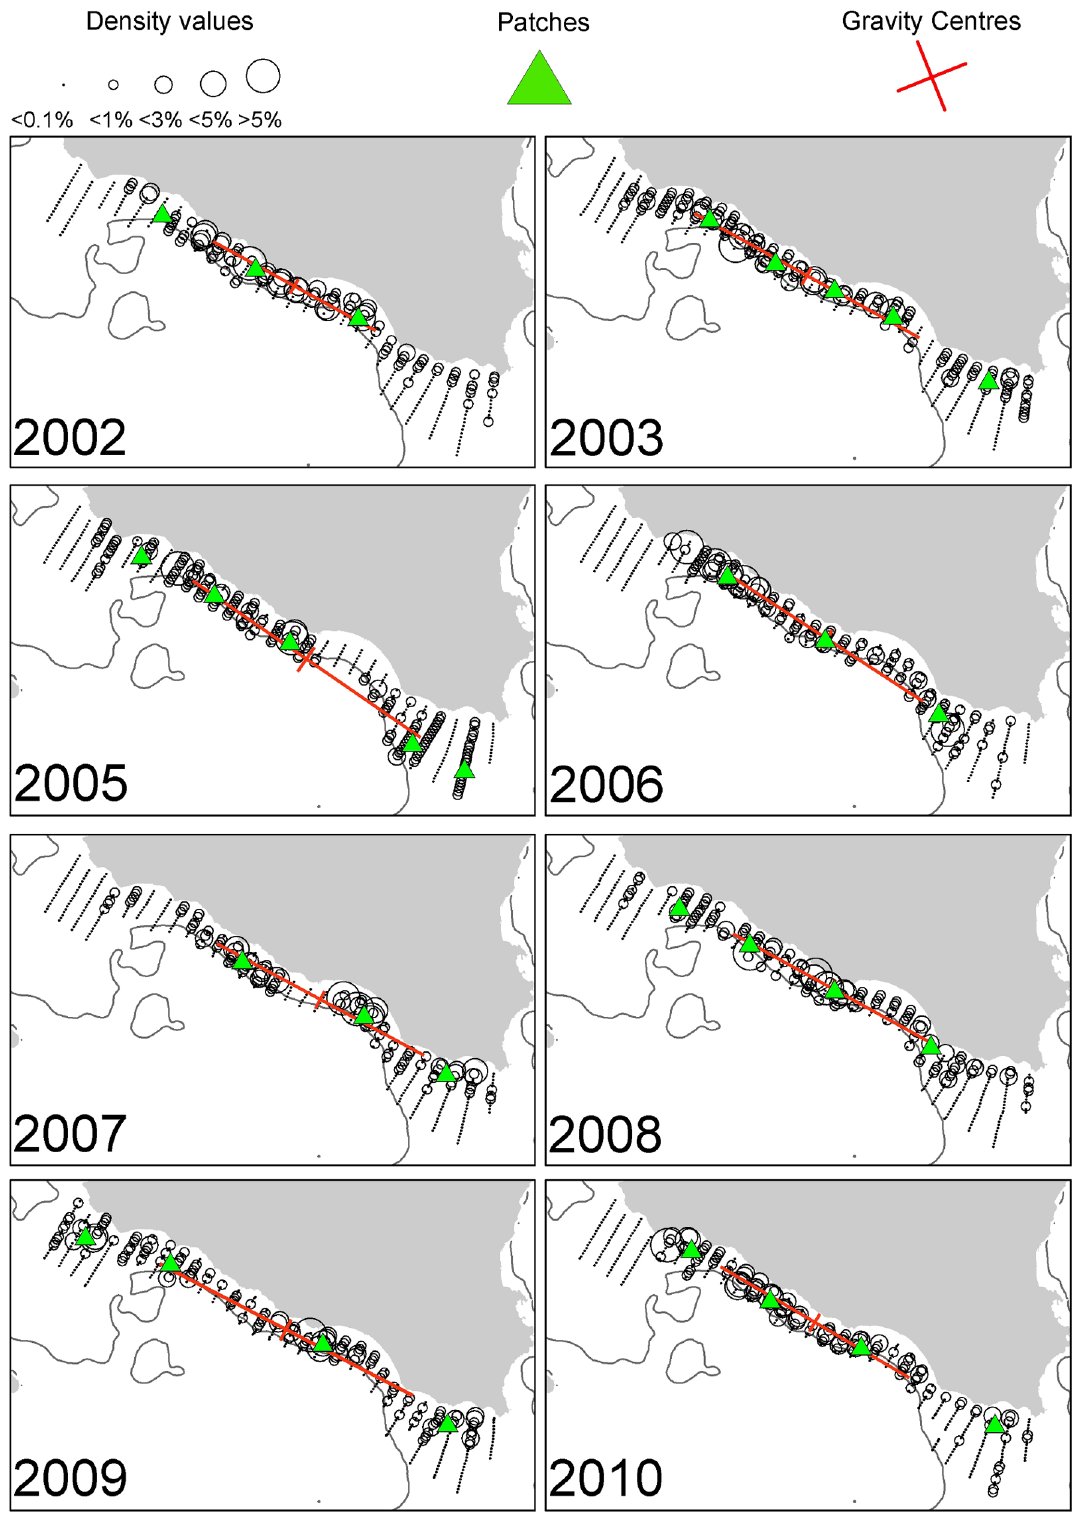
Fig 3. Annual maps of sardine density distribution in the Strait of Sicily during summertime. The position of the centres of gravity and the main spatial patches (contributing > 10% to total abundance) are shown. The 200 m isobath is indicated by a continuous line.